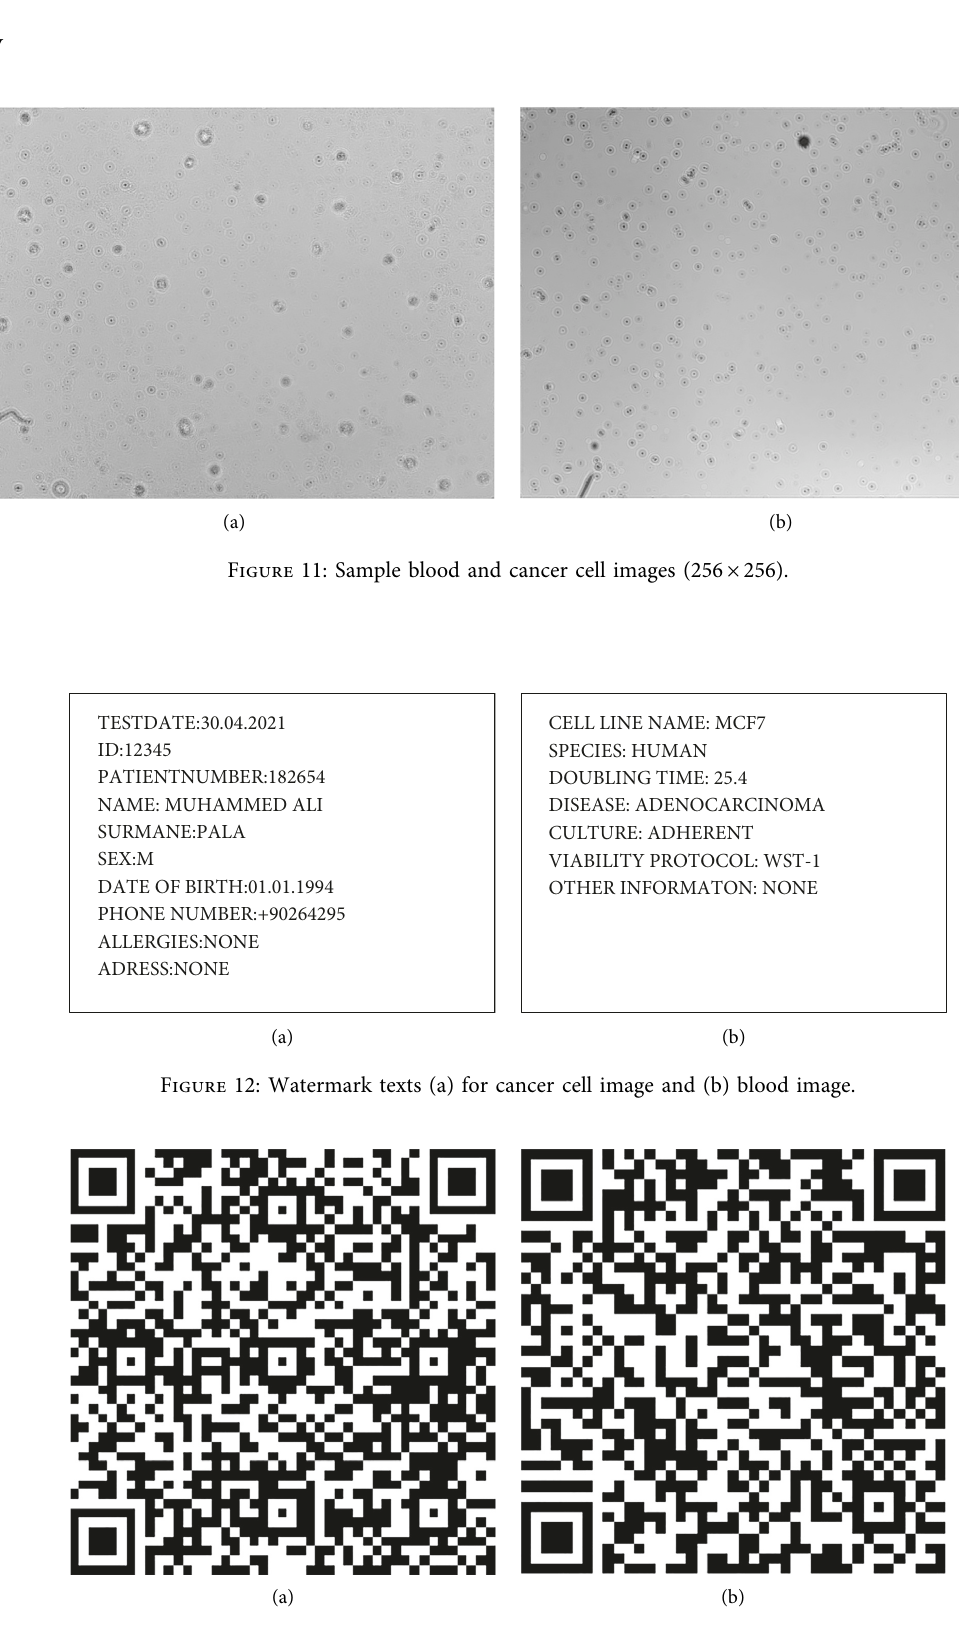
Figure 13: Watermark QR codes (256 × 256). (a) Watermark QR code for blood images and (b) cancer cell line